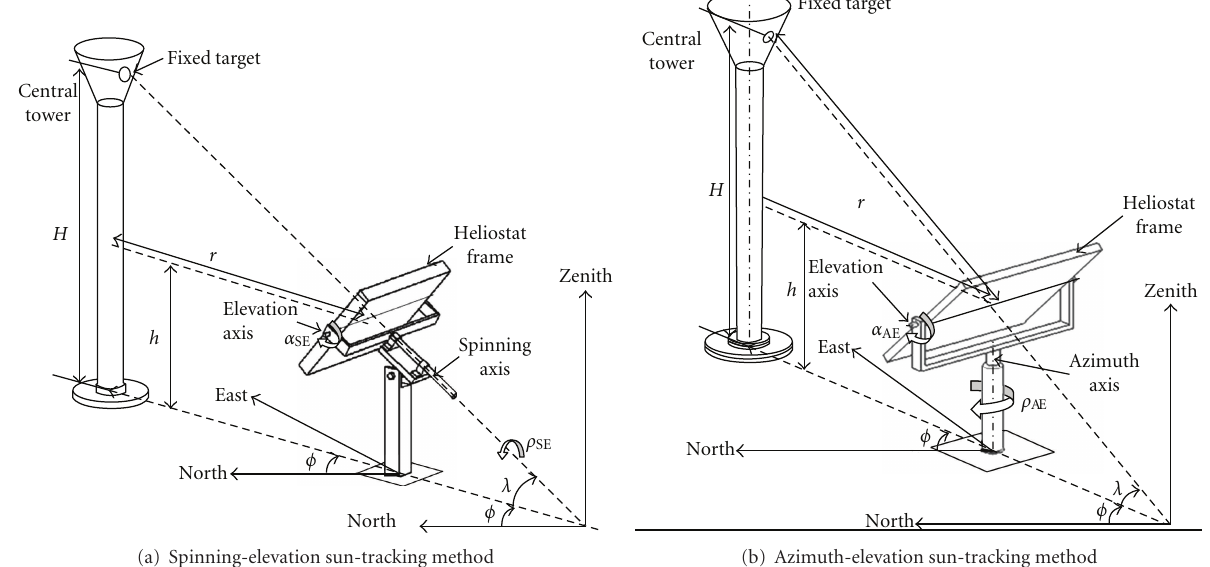
Figure 1: Coordinate system attached to earth-surface reference frame in which the central tower and heliostat are located for two di ff erent sun-tracking methods. φ is the facing angle, and λ is the facing angle of the heliostat. φ = 0 ◦ , when the heliostat is due south of the target and it is positive value if the spinning axis is rotated from north to east direction; λ = 0 ◦ if the heliostat is of the same height as the target and it is positive value when the spinning axis is rotated in such a way that the target is located higher than the